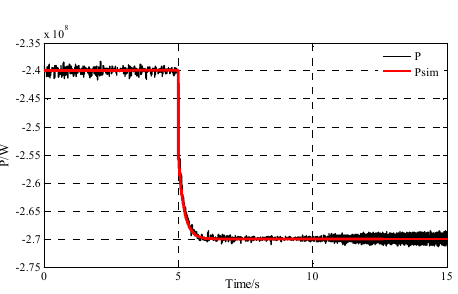
Figure 25. Comparison of active power waveform before and after equivalent during stable operation